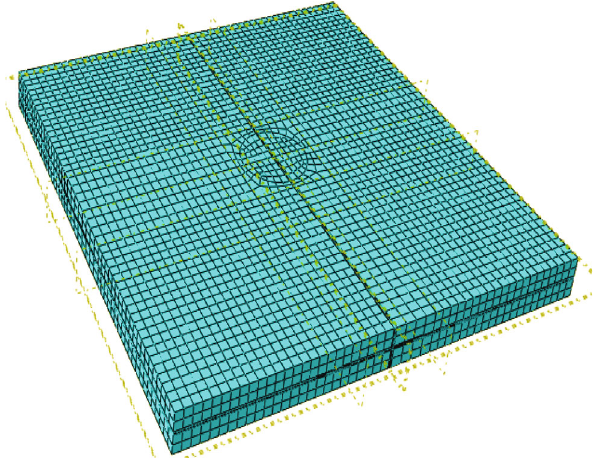
Figure 5: Finite element model after meshing.